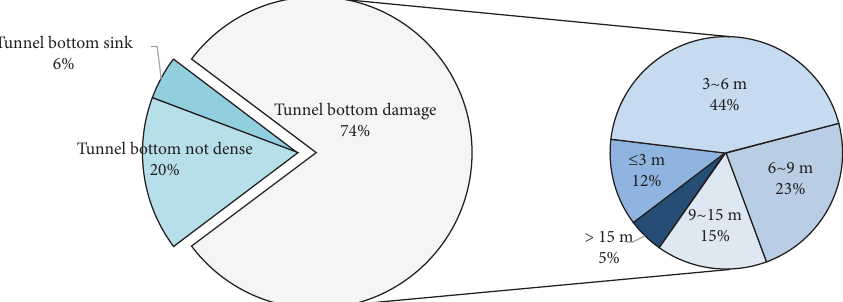
Figure 1: Main disease classifcation and continuous length diagram of tunnel bottom in the investigation section.